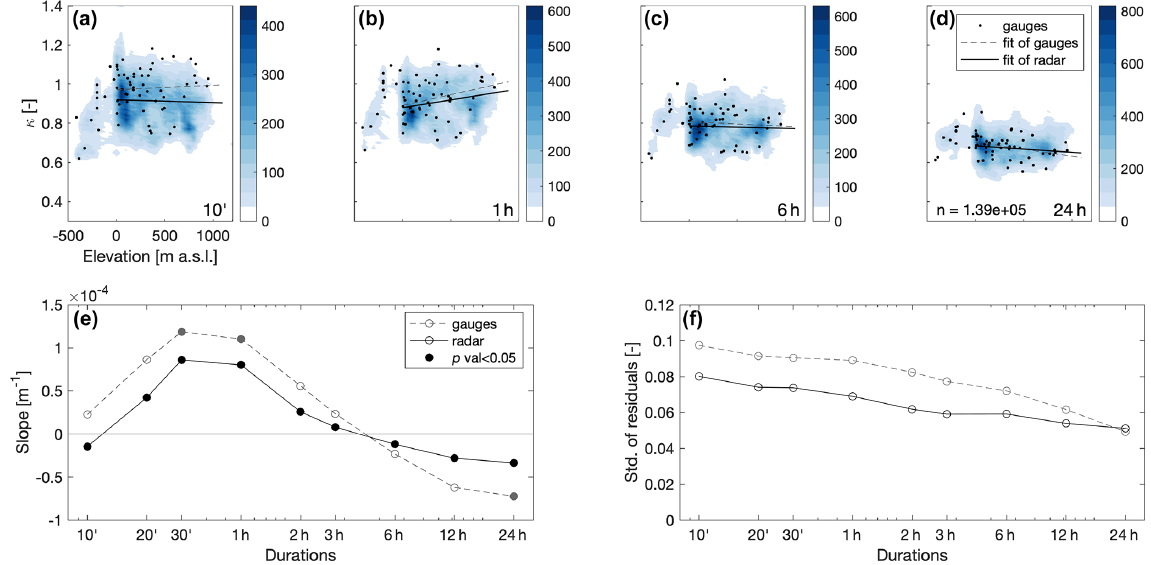
Figure 5. (a–d) Density plots of the shape parameter (representing the intensity distribution tail heaviness) as a function of terrain elevation for durations of 10min and 1, 6, and 24h. Color shading represents the number of pixels in bins of 50m by 0.01. Shape parameters estimated from the 10min rain gauges are shown as black dots. Regression lines computed for all the positive elevations (i.e., excluding the rift valley area depression, which shows a different behavior, and including slopes on both the east and west side of the Judaean Mountains) from weather radar (solid black lines) and 10min rain gauges (dashed gray lines) are shown. (e) Slope of the shape–elevation regressions computed from weather radar (solid black lines) and gauges (dashed gray lines) as a function of duration. Statistically significant slopes ( p < 0 . 05) are displayed with filled circles. Negative slopes imply an increase in tail heaviness with height and vice versa. (f) Standard deviation of the residuals around the regressions for weather radar (solid black lines) and gauges (dashed gray lines) as a function of